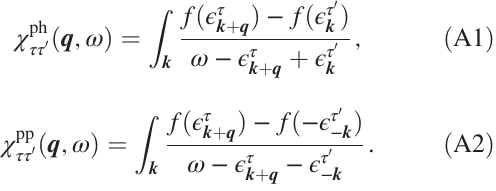
FIG. 6. (a) Reduced Brillouin zone in a triple- Q density-wave state. We assume the three ordering vectors Q which are parallel to the Γ − M lines and satisfy j Q j j ¼ Q − ¼ G= 4 . (b) Energy spectrum in the CDW − or collinear SDW − state with order parameter Δ ¼ 0 . 16 D . D is the original conduction bandwidth. There are 32 bands in the reduced Brillouin zone and the seventeenth band from the bottom is colored in red. Filling of 16 bands corresponds to the filling n ¼ 2